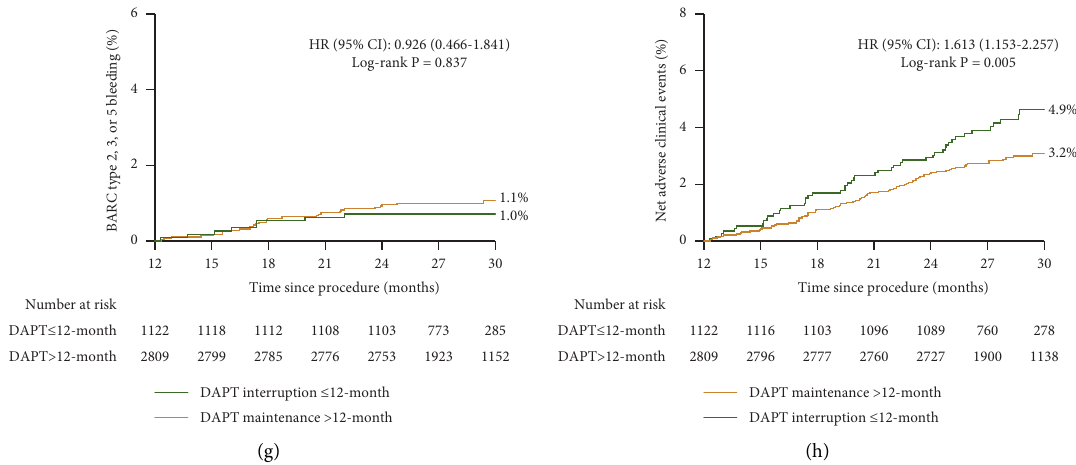
Figure 3: Time-to-event curves in patients with versus without interruption of DAPT within 12 months. (a) Major adverse cardiac and cerebrovascular events; (b) all-cause death; (c) cardiac death; (d) myocardial infarction; (e) stent thrombosis; (f) stroke; (g) BARC type 2, 3, or 5 bleeding; and (h) net adverse clinical events. Numbers at risk are shown below the basis (adjusted HR: 1.706, 95% CI: 1.133–2.596; P � 0 . 111) (Supplementary Figure 1(b)).